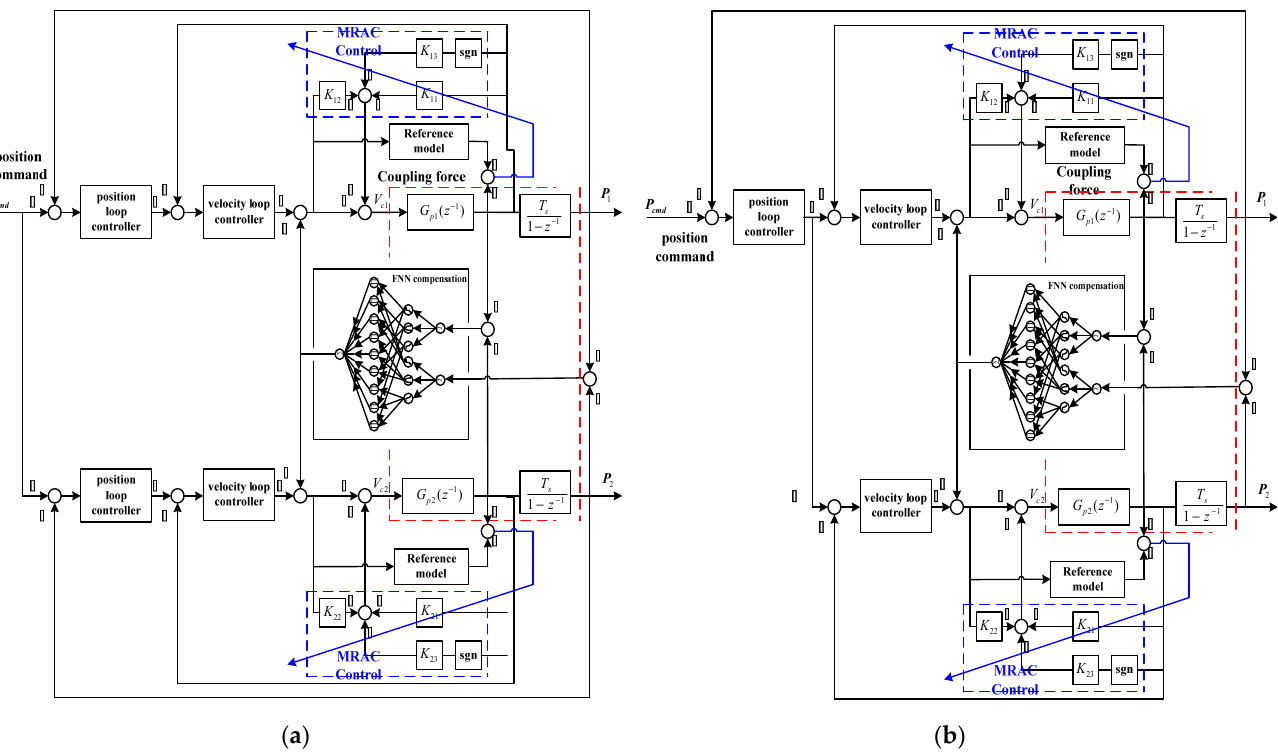
Figure 7. The proposed synchronous control methods of the gantry robot: ( a ) parallel control method; ( b ) parallel master–slave control method.